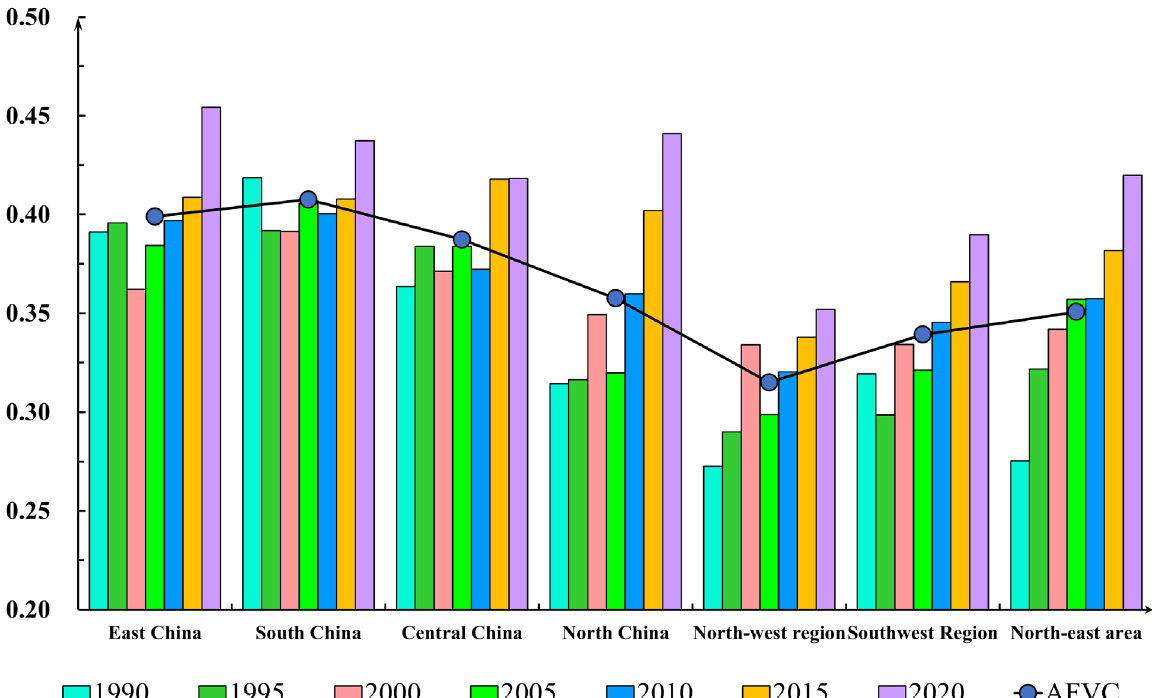
Figure 3. FVC changes in built-up areas of capital cities in seven geographic regions from 1990 to 2020.